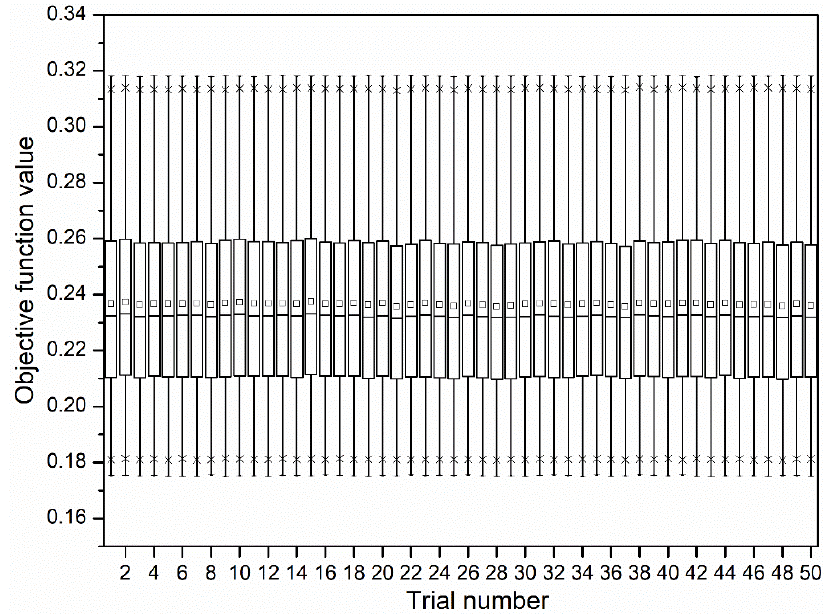
Figure 8. Comparison of total function evaluations of 50 trials.